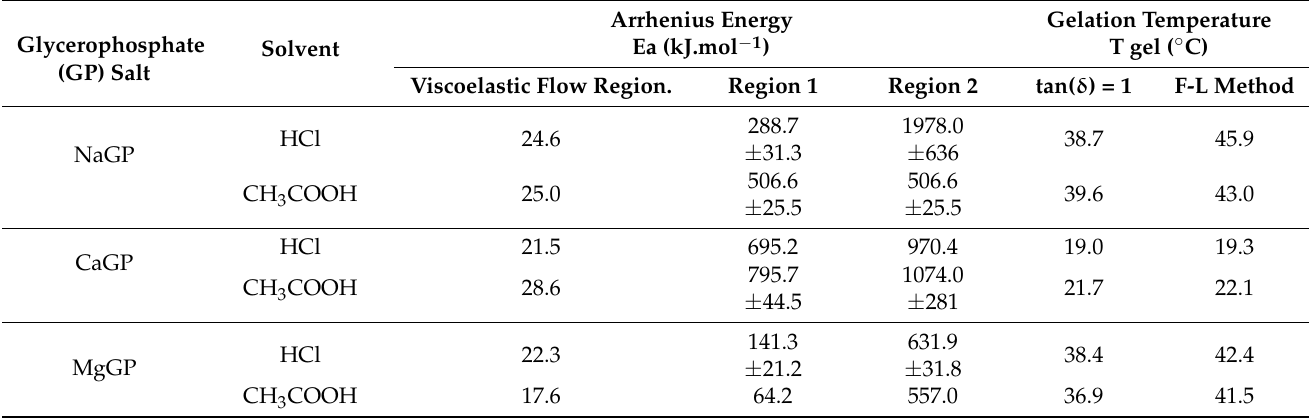
Figure 10. Experimental curves of changes in the values of the storage G’ and loss G” moduli obtained during non-isothermal measurements for chloride ( a – c ) and acetate ( d – f ) chitosan solutions containing sodium glycerophos phate, calcium glycerophosphate, and magnesium glycerophosphate. Table 1. Arrhenius energy values in the fast gelation area and energy in the viscoelastic flow region as well as the phase transition